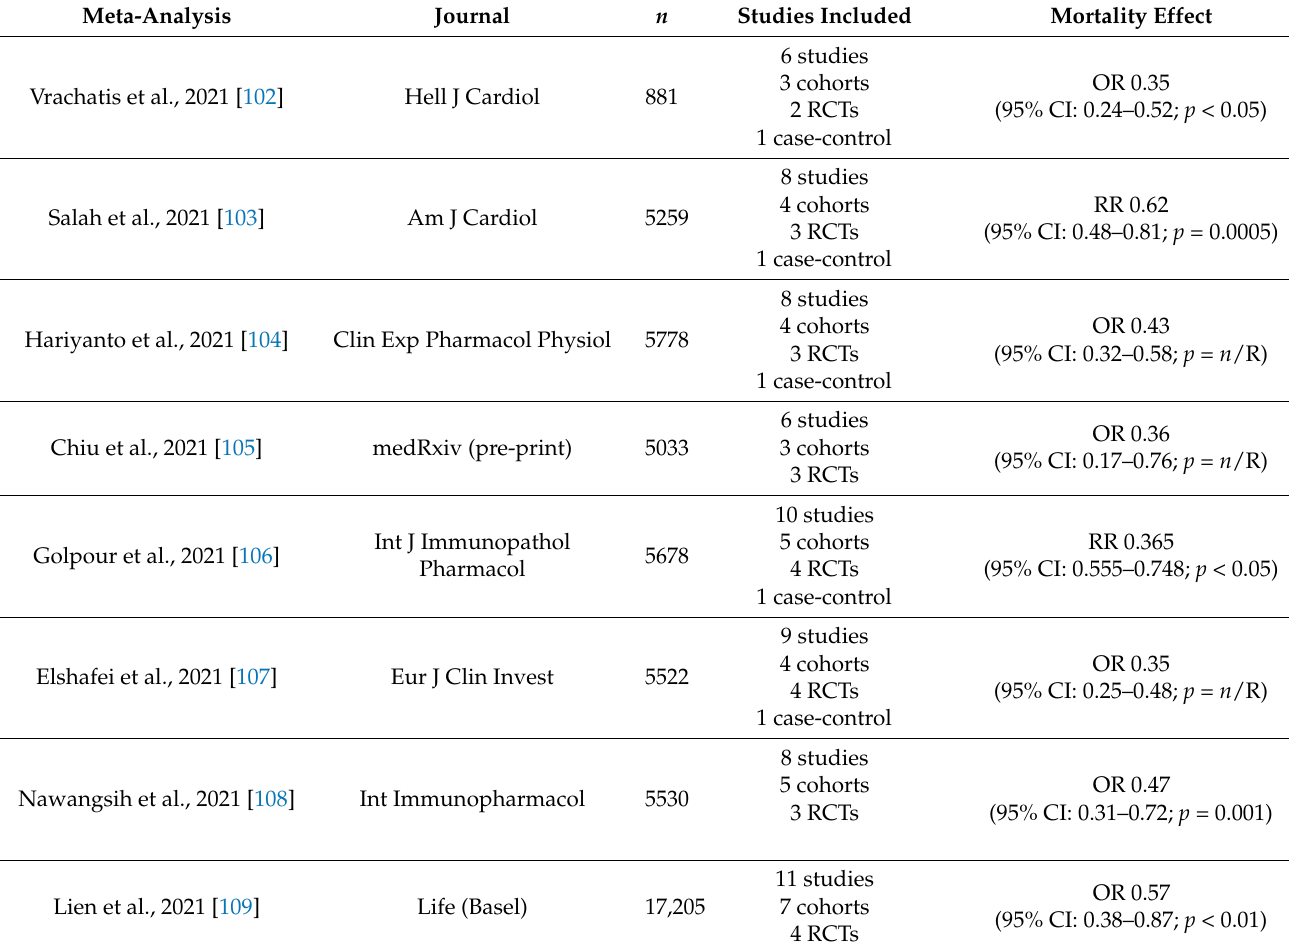
Table 3. 8 meta-analyses reporting effect of colchicine administration in COVID-19 mortality. (Abbreviations: OR odds ratio, RR relative risk, CI confidence interval, n /R not reported, n population, RCTs randomized clinical trials).